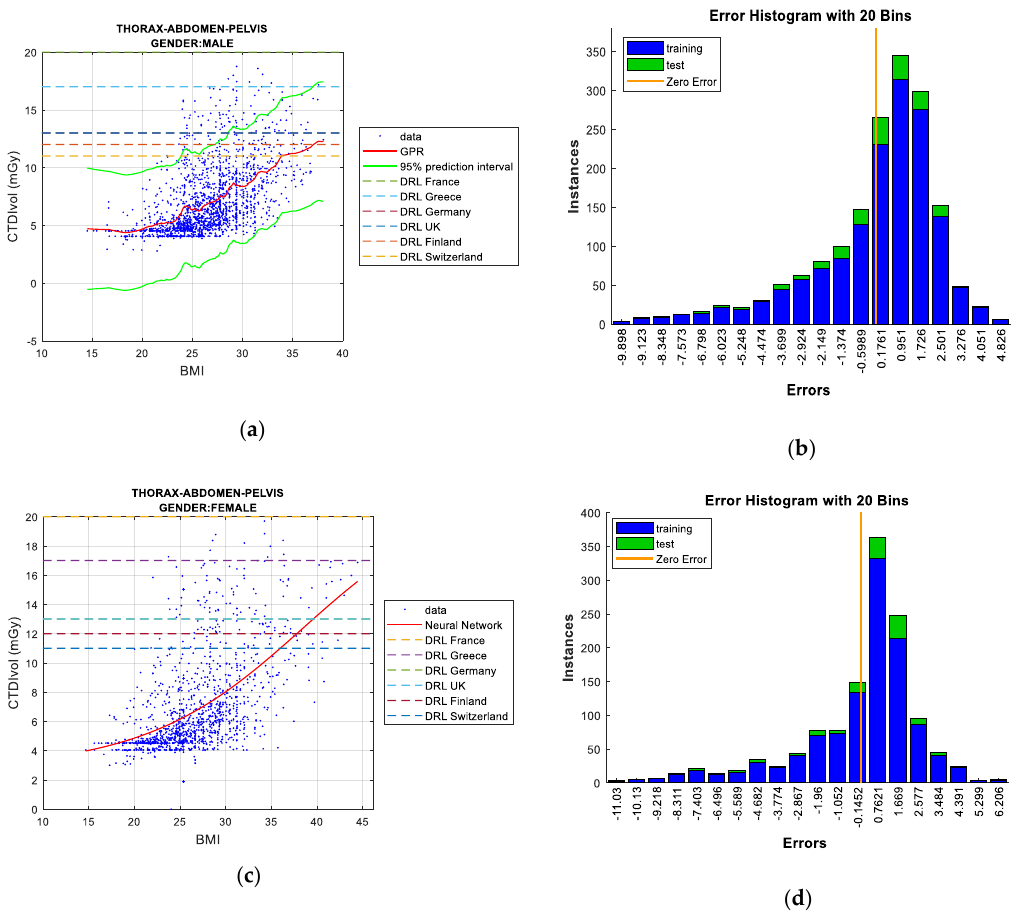
Figure 6. CTDI VOL prediction according to BMI including European DRLs for men’s / women’s thorax, abdomen & pelvis protocol ( left ), together with error histograms ( right ), employing the Gaussian Process Regression (GPR) technique for men; ( a , b ), and the Neural Networks for women; ( c , d ). Table 8. BMI-CTDI VOL results for men’s Abdomen & Pelvis